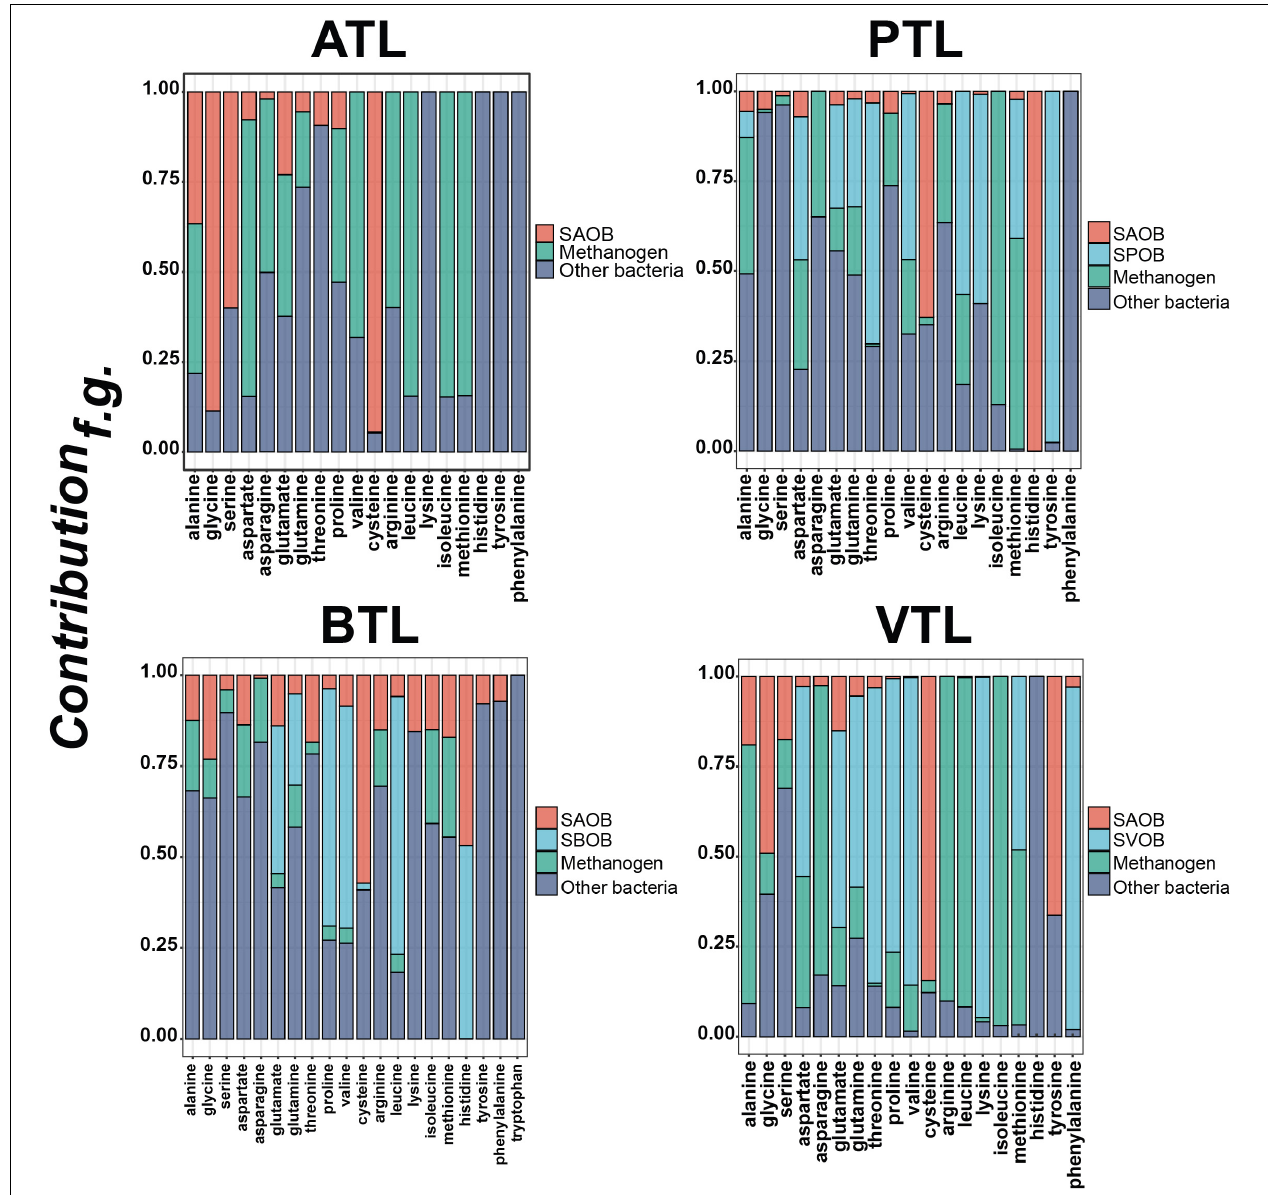
FIGURE 5 | The contributions of different functional groups to amino acid synthesis in each chemostat. The ATL, PTL, BTL, and VTL represent the thermophilic methanogenic chemostats supplemented with acetate, propionate, butyrate, and isovalerate as sole carbon source, respectively. We quantified the relative contribution of AA synthesis of each functional group by defining Contribution f . g . . Details on the definition are described in “Materials and Methods” section. More details about the contributions of different functional groups to the synthesis of each AA are shown in Supplementary Figure 7